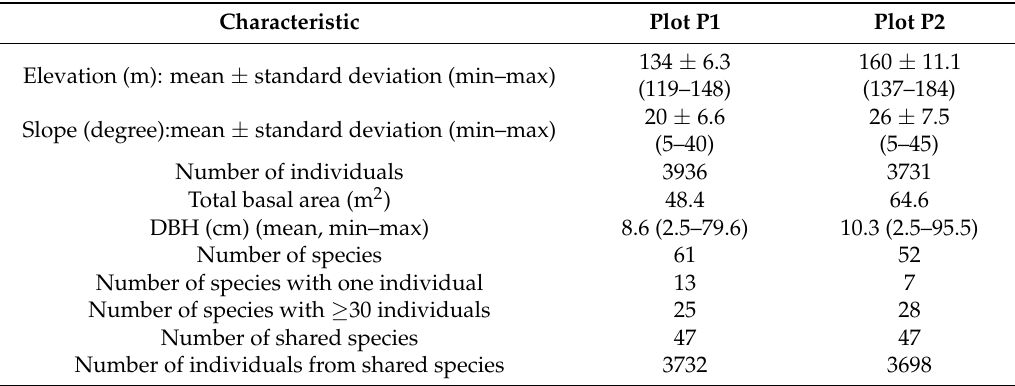
Table 1. Basic description of two sampled